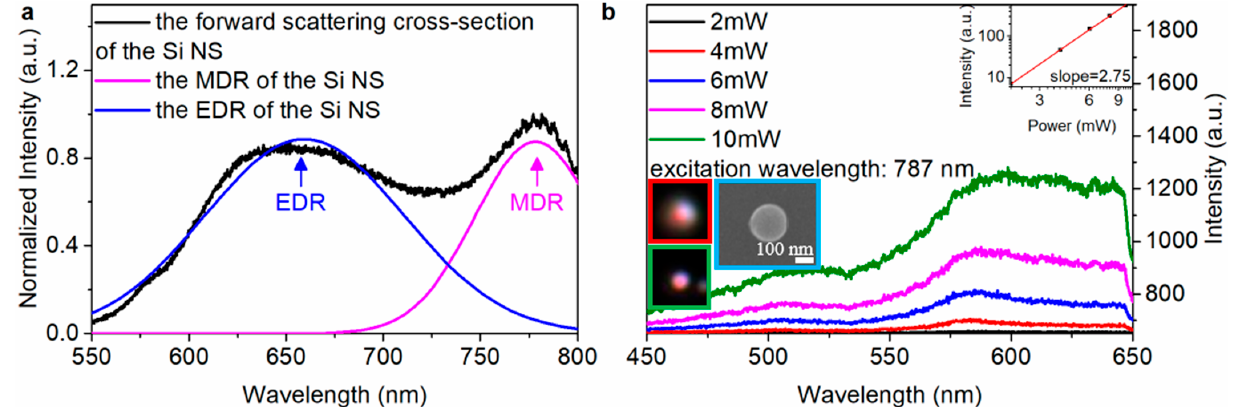
Figure 1. The experimental (black line) forward scattering cross ‐ section ( a ) and the dependence of the nonlinear response on the excitation power ( b ) of Si NS. The inset shows the slope of the luminescence intensity of the Si NS versus excitation power. The red, green and cyan insets are the luminescence image, the dark field image and SEM image of Si NS, respectively.